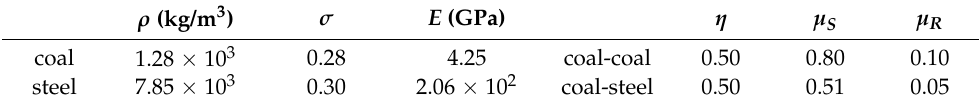
Figure 8. The comparison of calibration results between experiment and DEM. Table 1. The material parameters in DEM.